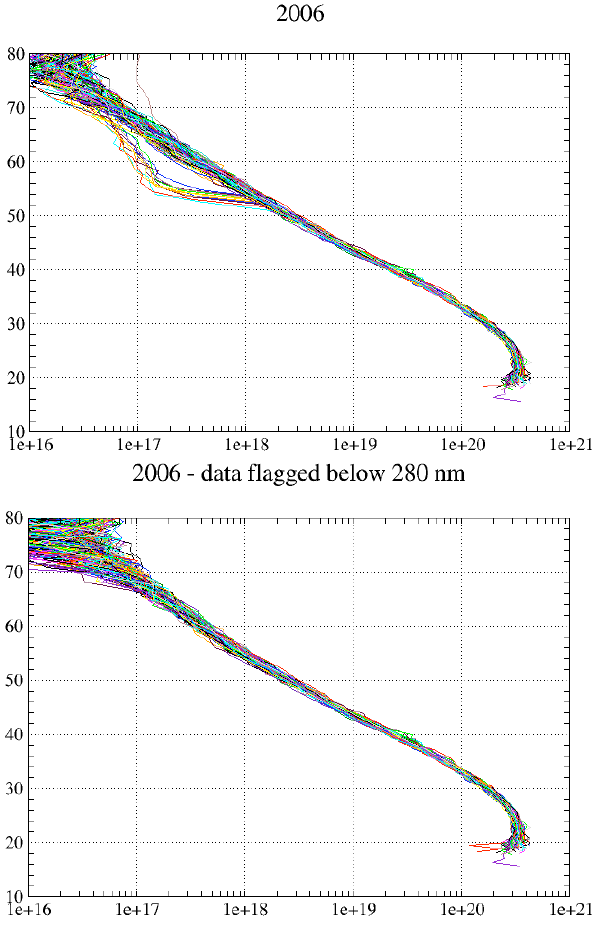
Fig. 3. O 3 line density profiles obtained with a dim star S143 in 2006 using the GOPR v6.0cf processing (left panel) and the same set of profiles re-calculated removing a part of the spectrum (240–280nm).